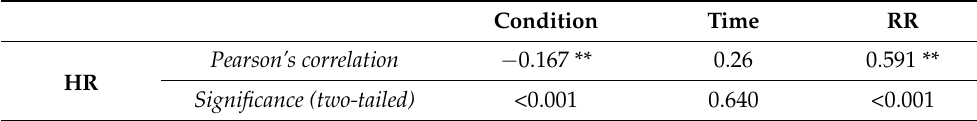
Table 5. Results of the correlation analyses of heart rate (HR), respiratory rate (RR), temporal phase, and conditions.